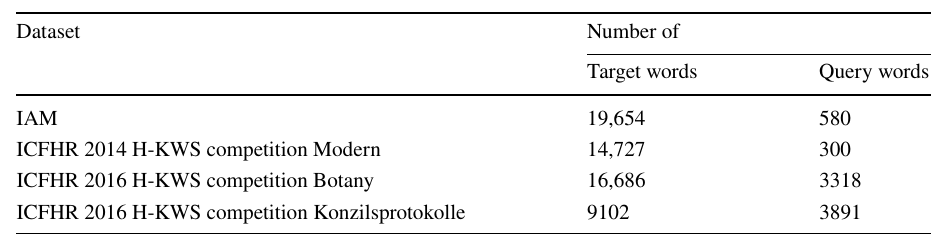
Table 1 Word distribution in the datasets used in the present work